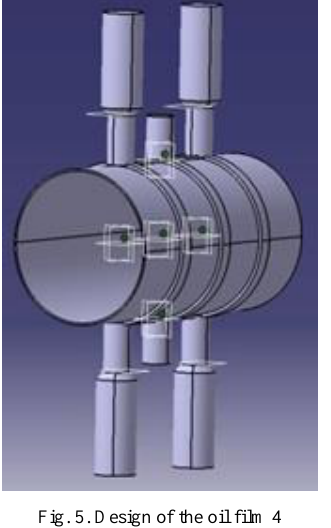
Fig. 5. Design of the oil film 4